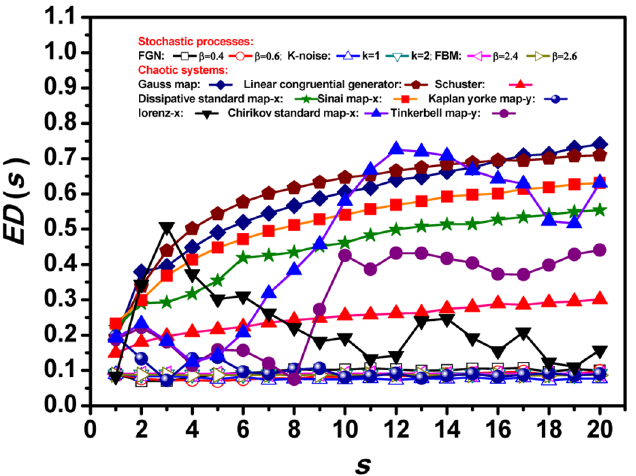
Fig 2. The changing values of ED ( s ) with scale factors for different SPs and CSs. It can be taken as a sensitive measure of the underlying dynamics.